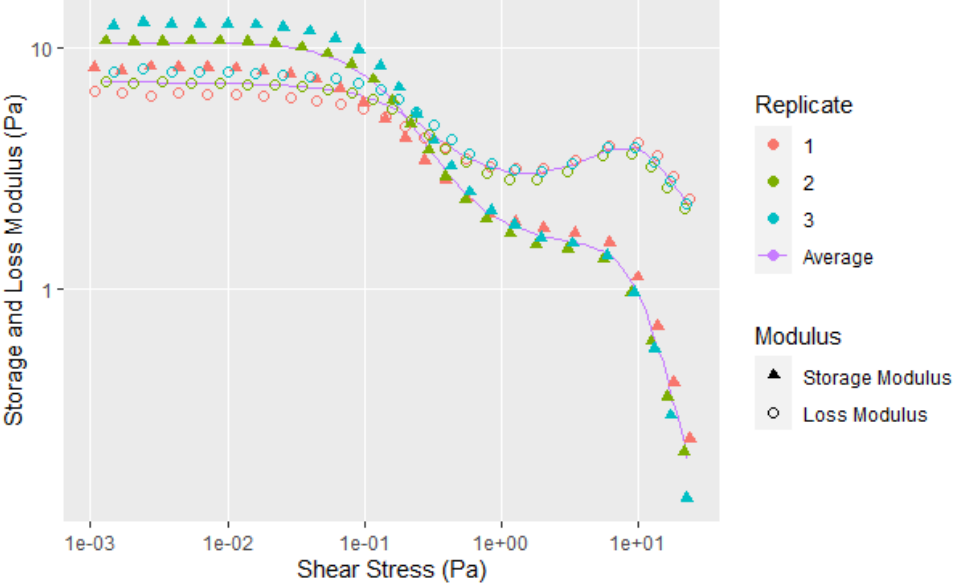
Figure A3. Individual amplitude sweep data for mixtures of 90 PDI flour with 1 h mixing time and 20% solid content.